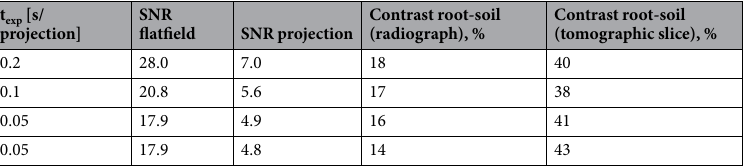
Table 1. Overview on signal to noise ratios and contrast between roots and soil measured for the initial test